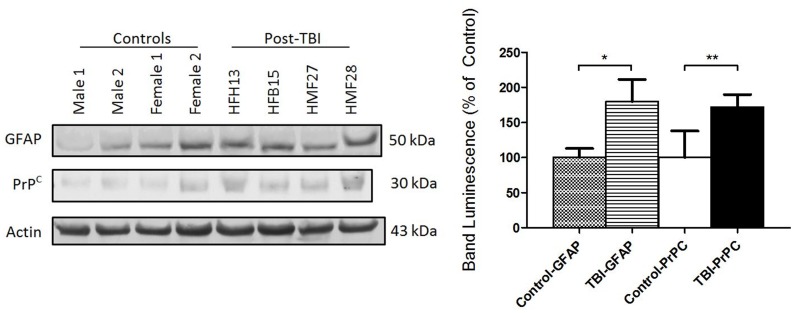
Western blot for protein biomarkers.Semi-quantitative band density analysis determined that both GFAP and PrPC protein content were significantly elevated in post-TBI samples (n = 4) in comparison to randomly selected controls (n = 8). All bands were normalized to housekeeping protein actin. Mean post-TBI GFAP band intensity was higher (180.0% ± 31.4% SEM) than in controls (100% ± 13.0%) (two-tailed t-test, p<0.034). Mean post-TBI PrPC band intensity was also higher (171.9% ± 18.0%) than in controls (100.0% ± 11.0%) (two-tailed t-test, p<0.0025).